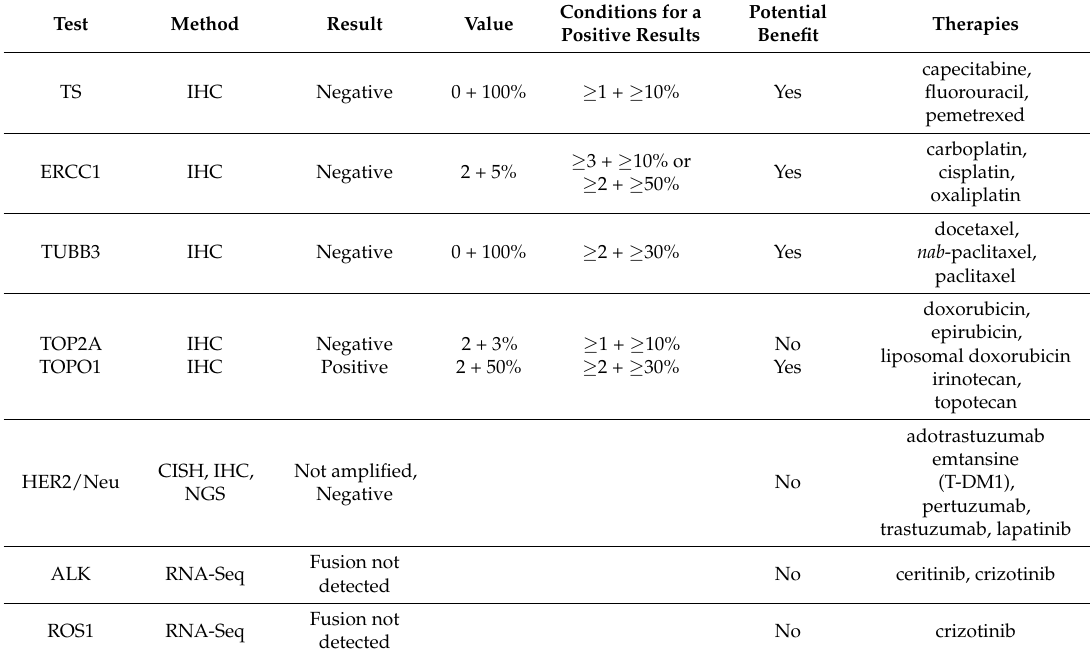
Table 1. Biomarker analysis and associated